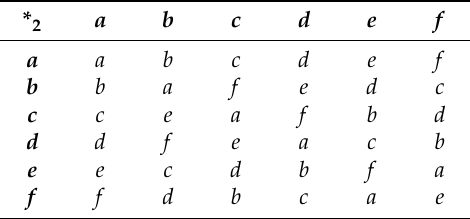
Table 12. The operation * 2 on non-commutative perfect NETG N 2